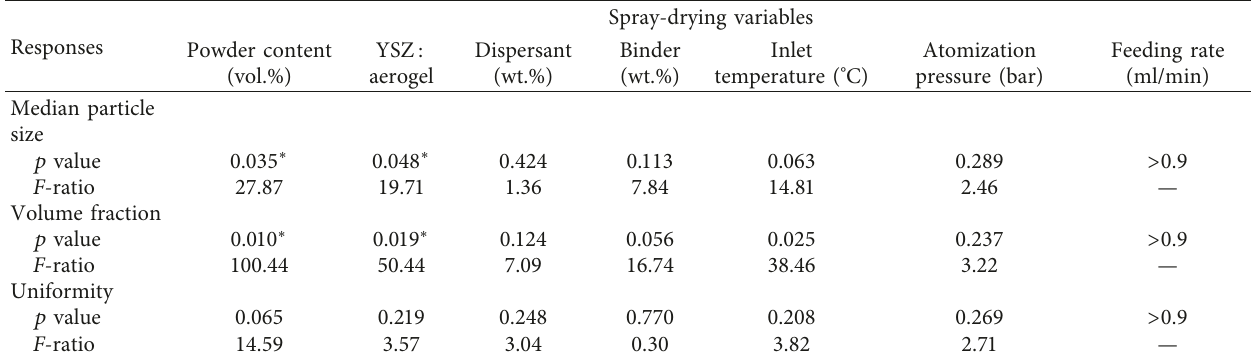
Table 3: Significant effect of each independent variable on the spray-dried powder characteristics.